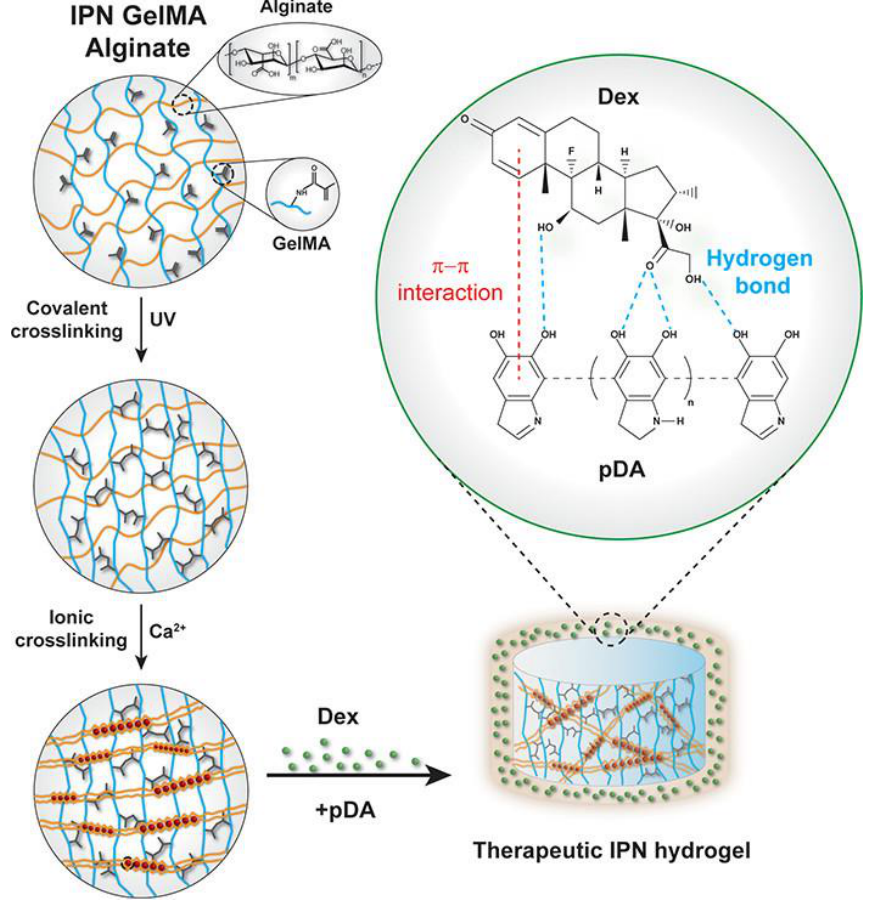
Figure 1. Schematic representation of synthesis of IPN-type hydrogel. Reproduced with the per- mission of [32] , Copyright 2018 American Chemical Society.